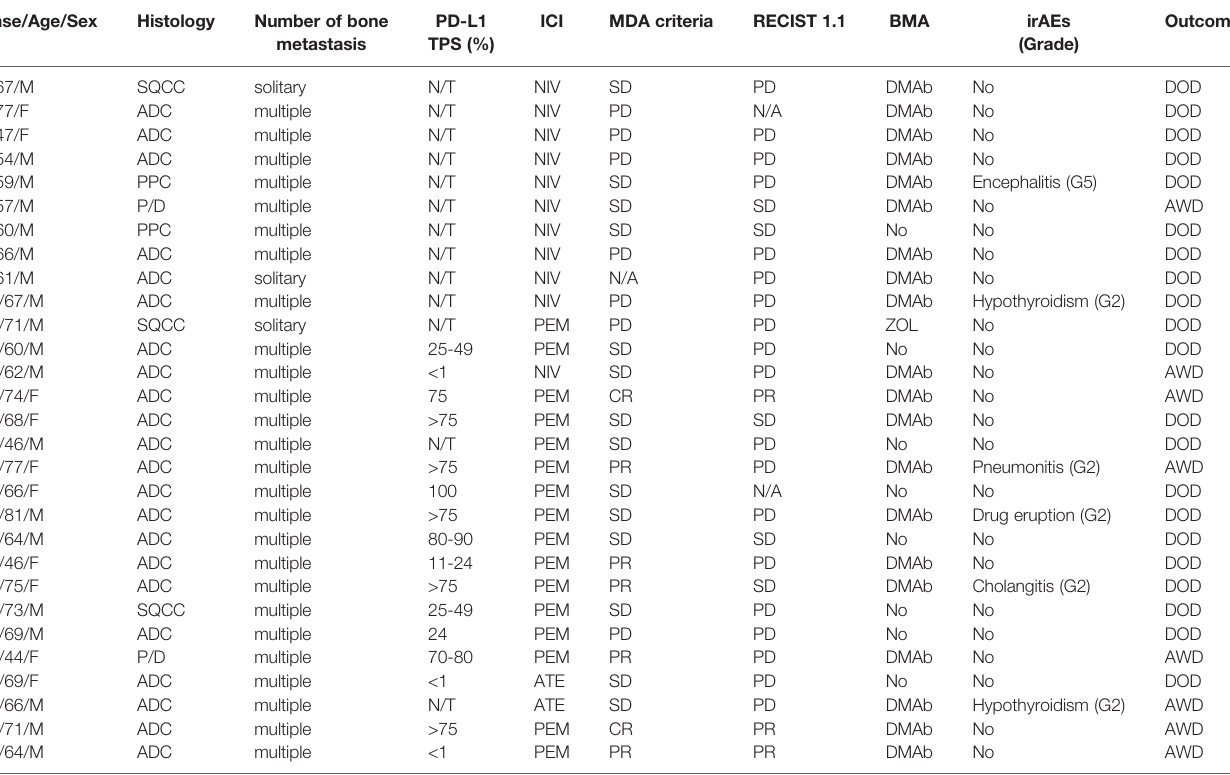
TABLE 4 | Patient characteristics, disease features, treatment details, and outcomes of study population. Case/Age/Sex